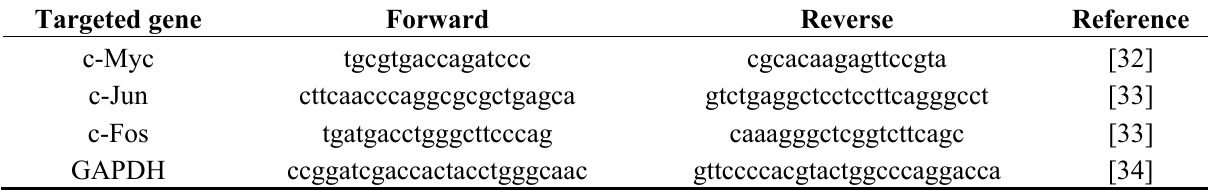
Table 4. Characteristics of the PCR primers sets used for gene expression